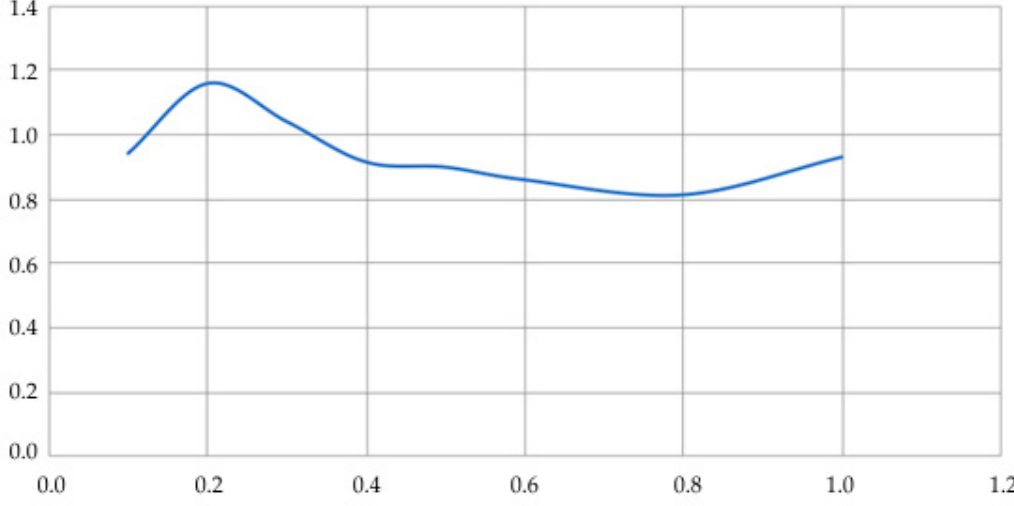
Figure 8. Dependence C ( E i , ρ i , h i ) on thickness h 4 of the surface layer E 4 at E 4 = 1600 MPa (asphalt concrete).